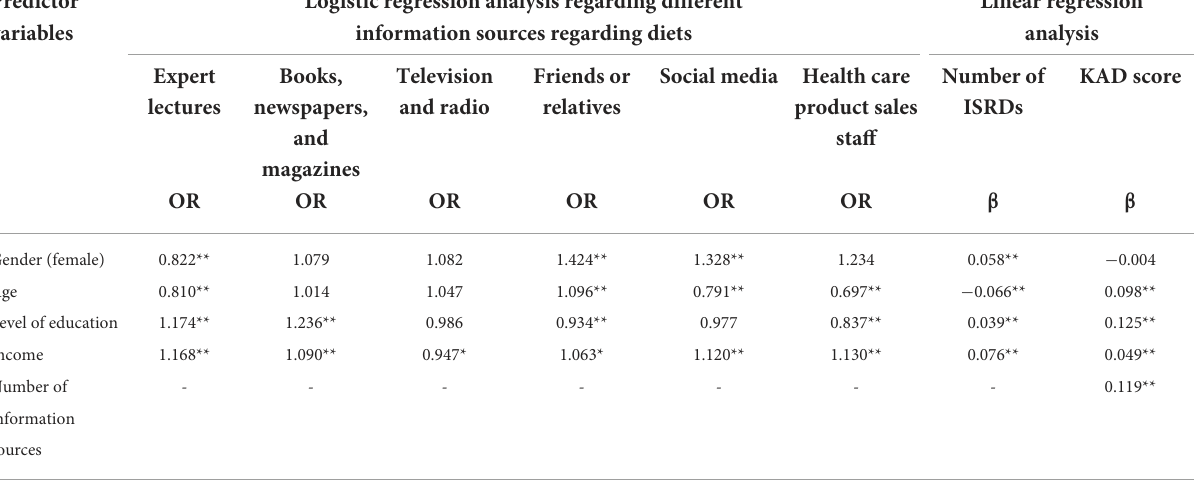
TABLE 4 Multiple regression coefficients (odds ratio, standardized β ) for socio-economic variables in terms of different information sources regarding, reasonable diets (ISRDs) associated with knowledge of adequate diets (KAD) score.